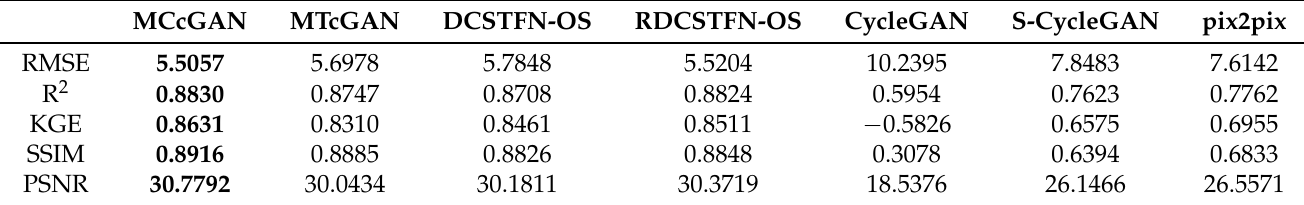
Table 3. The evaluation metrics of different methods for the red band in Area A at Time II (the bold result is the best among the different metrics, MCcGAN: Multi-channels Conditional Generative Adversarial Network, MTcGAN: Multi-temporal Conditional Generative Adversarial Network, DCSTFN-OS: Deep Convolutional Spatiotemporal Fusion Network for SAR-to-Optical Task, RDCSTFN-OS: Residual Deep Convolutional Spatiotemporal Fusion Network for SAR-to-Optical Task, CycleGAN: Cycle-consistent Adversairal Network, S-CycleGAN: Supervised Cycle-consistent Adversairal Network, RMSE: root-mean-square-error, KGE: Kling Gupta efficiency, SSIM: structural similarity index, PSNR: peak signal-to-noise ratio).